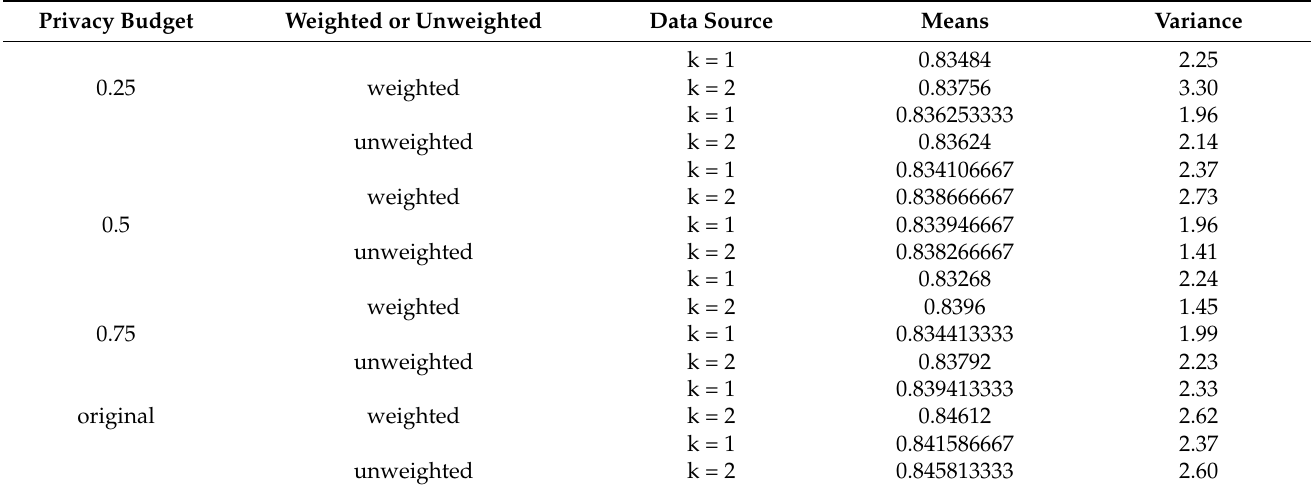
Table 7. The performance of the initial global model H 2 in t 3 of the federated average algorithm.